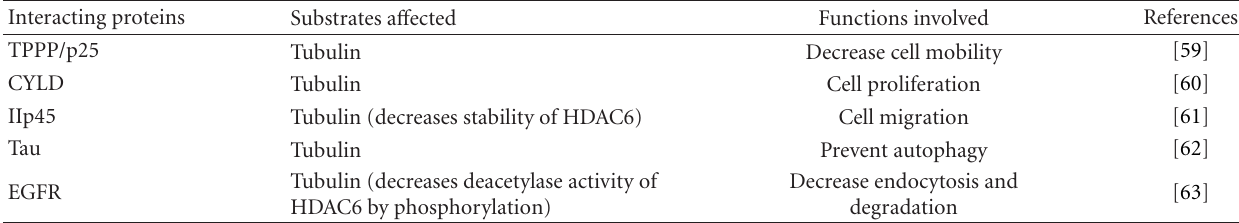
Figure 2: Regulation and functional ramifications of the HDAC6 deacetylase activity. Interaction with protein partners reduces protein deacetylase activity of HDAC6, which is important for the deacetylation of substrate proteins and cellular e ff ects as indicated. Table 3: Proteins interacting with and inhibiting the deacetylase activity of